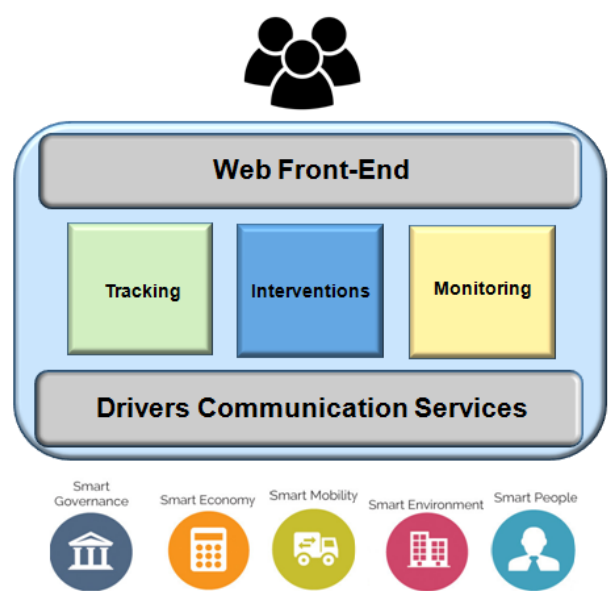
Figure 29. Illustration of the Carriots architecture.